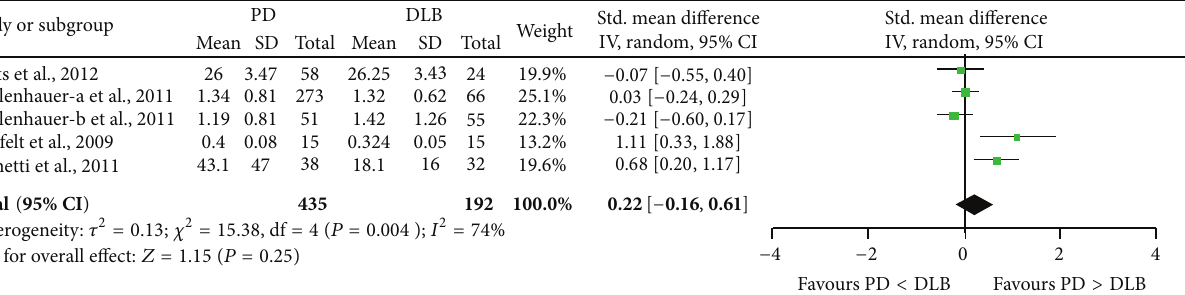
Figure 5: Forest plot of CSF 𝛼 -syn levels in PD compared to DLB.